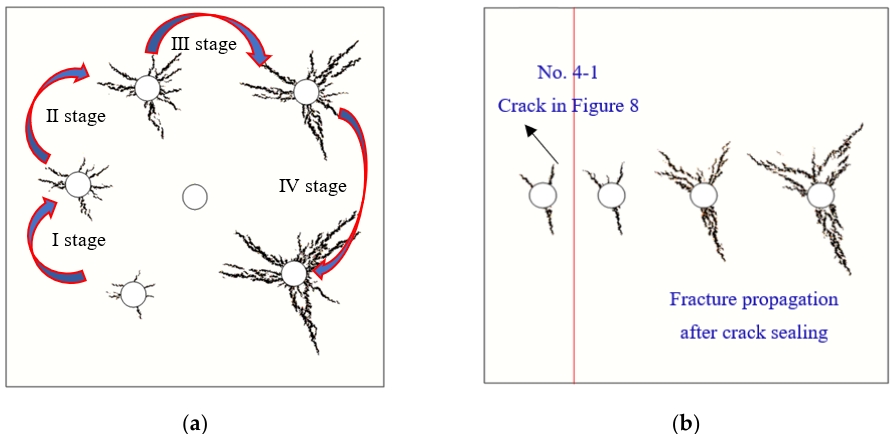
Figure 20. Crack propagation law of fracturing hole considering particle plugging measures before and after hydraulic fracturing: ( a ) particle plugging before hydraulic fracturing; ( b ) particle plugging after hydraulic fracturing.